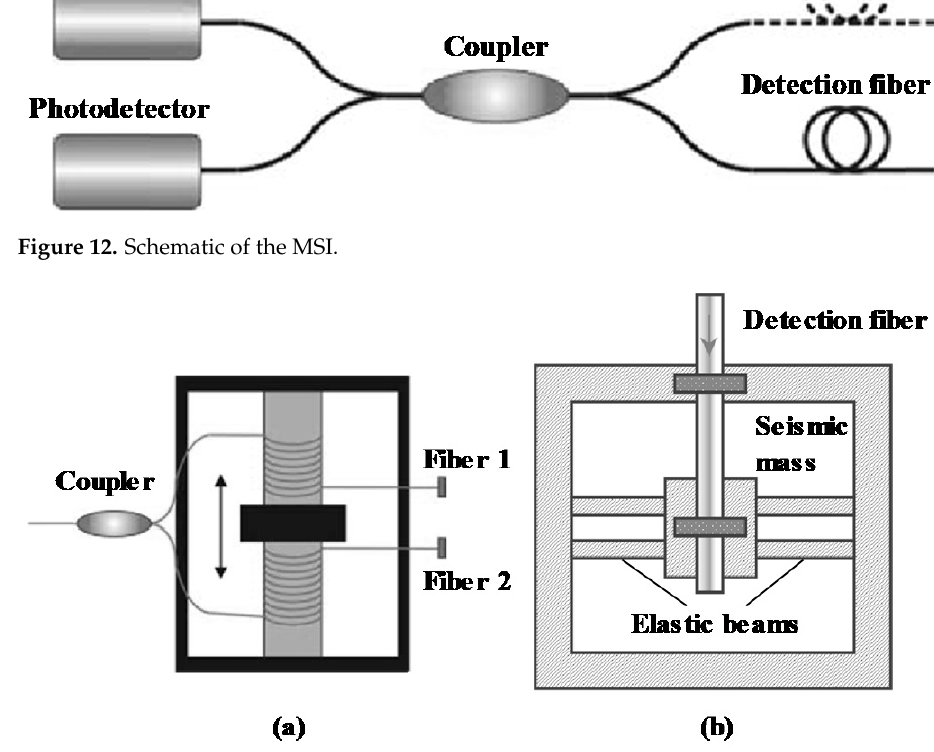
Figure 13. MSI-based accelerometer: ( a ) elastic cylinder and ( b ) elastic beam. MZI is similar to MSI. Although both are two-beam interferometers, the difference is that MZI does not use end-face reflection, but instead, couples two beams to interfere for a transmission interferometer, as shown in Figure 14. The phase shift ∆ ϕ from the strain caused by the acceleration a is